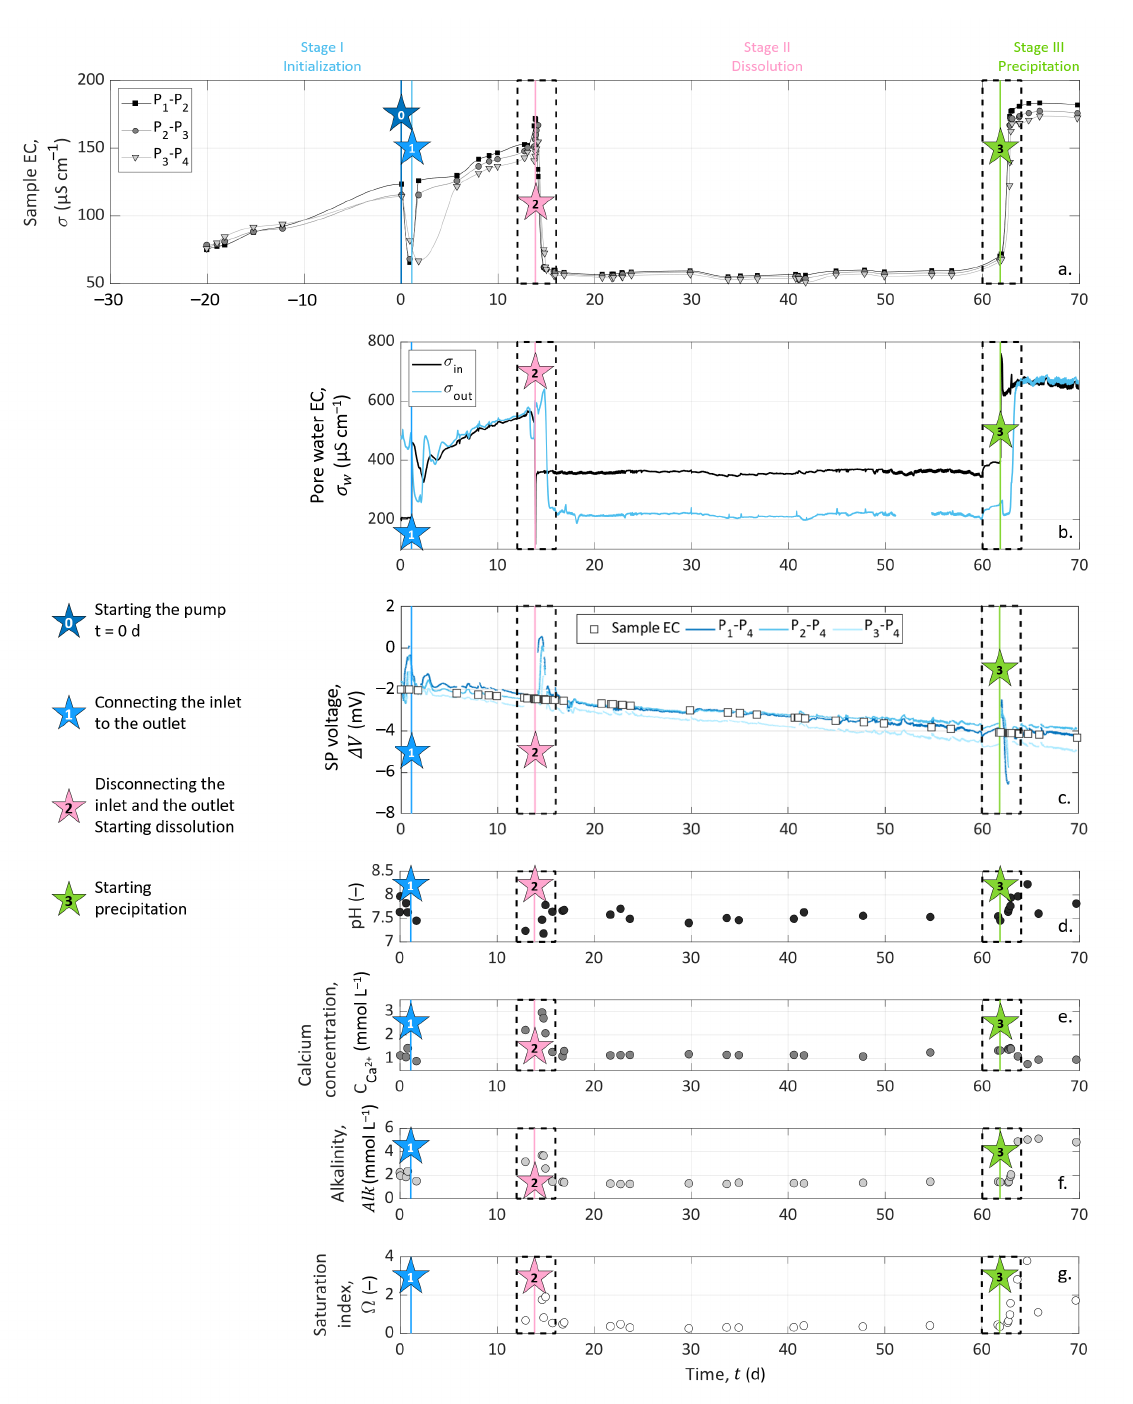
Figure 4. Measurements were performed during the laboratory experiment. The dashed boxes are the delimitation of the zoomed-in views presented in Figure 5. ( a ) Sample EC. ( b ) Inlet and outlet pore water EC. The data gap of the outlet water EC curve comes from an acquisition interruption due to the conductivity meter flat battery. ( c ) SP curves were measured on three channels of acquisition, using electrode P 4 as the reference. The white squares represent the interruption of SP acquisition to measure sample EC instead. ( d – f ) pH, calcium concentration C , and alkalinity of the water Ca 2 + sampled at the outlet of the column, respectively. ( g ) Saturation index for calcite computed from outlet pore water chemical